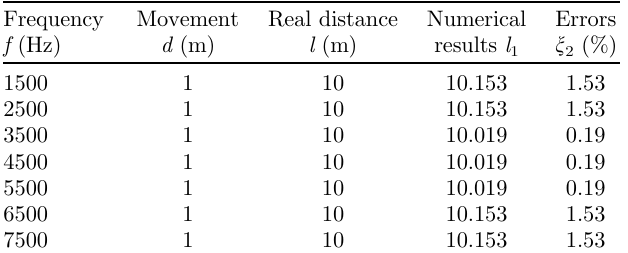
Table 2. Underwater sound localization when the frequency f is 1500 – 7500 Hz.